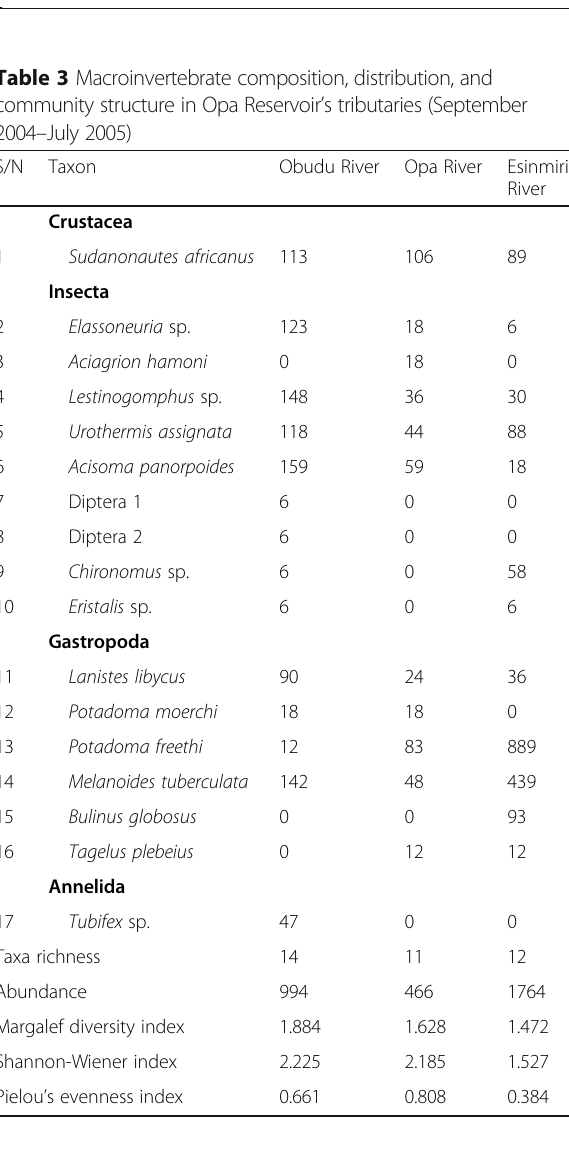
Fig. 3 Taxa richness of the dominant groups of macroinvertebrates in Obudu, Opa, and Esinmirin rivers